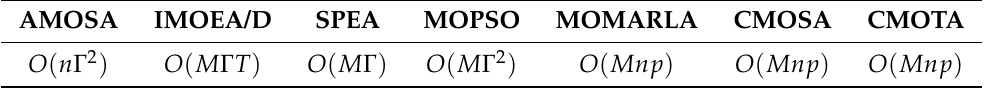
Table 10. Complexity of the